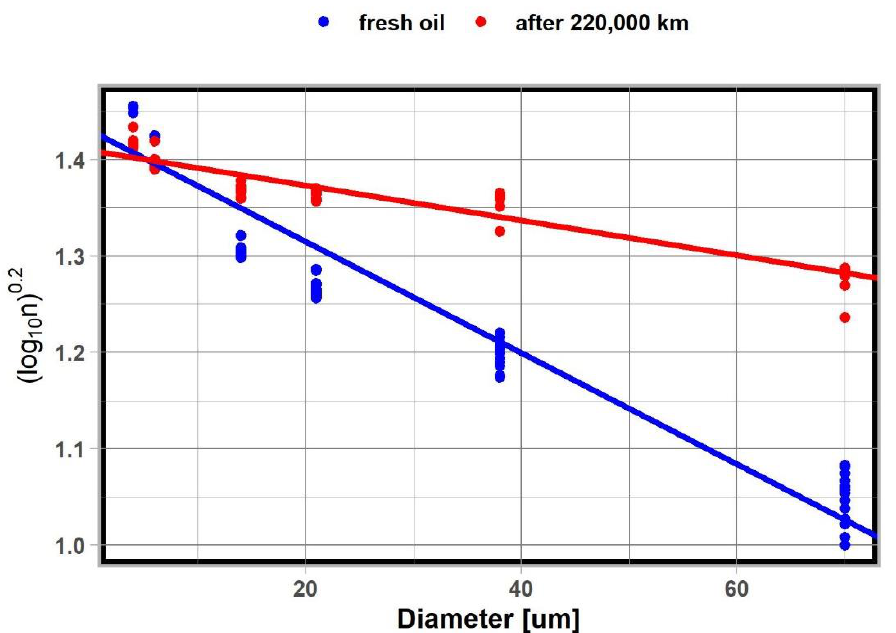
Figure 9. Regression model of particle content as a function of particle diameter of fresh and used (220,000 km) gear oil SAE 80W-140. Table 4. Basic parameters of the linear regression model for oil SAE 80W-140.